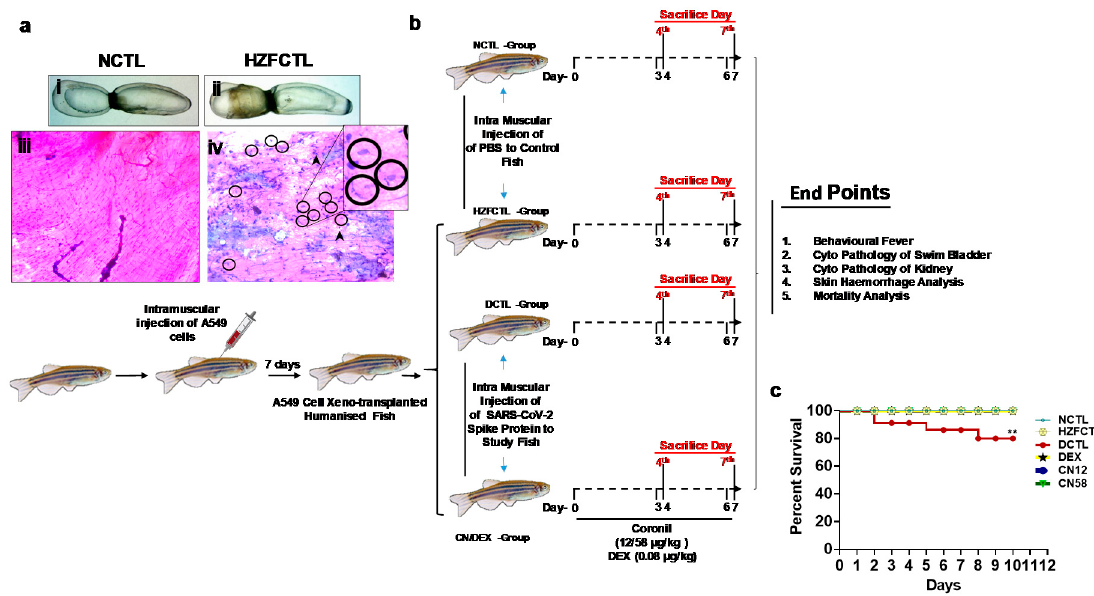
Figure 2. Study design of SARS-CoV-2 spike protein induced pathology using humanized xeno-transplanted zebrafish. ( a ) Representative images of swim bladders from ( i ) NCTL and ( ii ) HZFCTL post 7-day transplant showing normal morphological traits. Cyto-smears of ( iii ) NCTL and ( iv ) HZFCTL showed normal cytological features along with transplanted cells (zoom-in represents xeno-transplanted cells). Black arrows indicate cells of zebrafish origin and black circle represent cells of human origin. AL—anterior lobe, PL—posterior lobe. Scale bars, 1000 µ m at 1X magnification. ( b ) Schematic representation of zebrafish model of SARS-CoV-2 spike protein induced pathology. Humanized zebrafish ( n = 24 in each group) were injected with SARS-CoV-2 spike protein (Disease Control, DCTL) or PBS (Normal Control, NCTL and Humanized zebrafish control, HZFCTL) and treated with two di ff erent doses of Coronil, 12 µ g / kg (CN12) and 58 µ g / kg(CN58) and DEX (0.08 µ g / kg) for two time points followed by necropsy and endpoint measurement. ( c ) Kaplan-Meier survival curves following SARS-CoV-2 spike protein challenge and pharmacological treatment with DEX and Coronil till 10th day. n = 24. Log rank test ** p < 0.001.